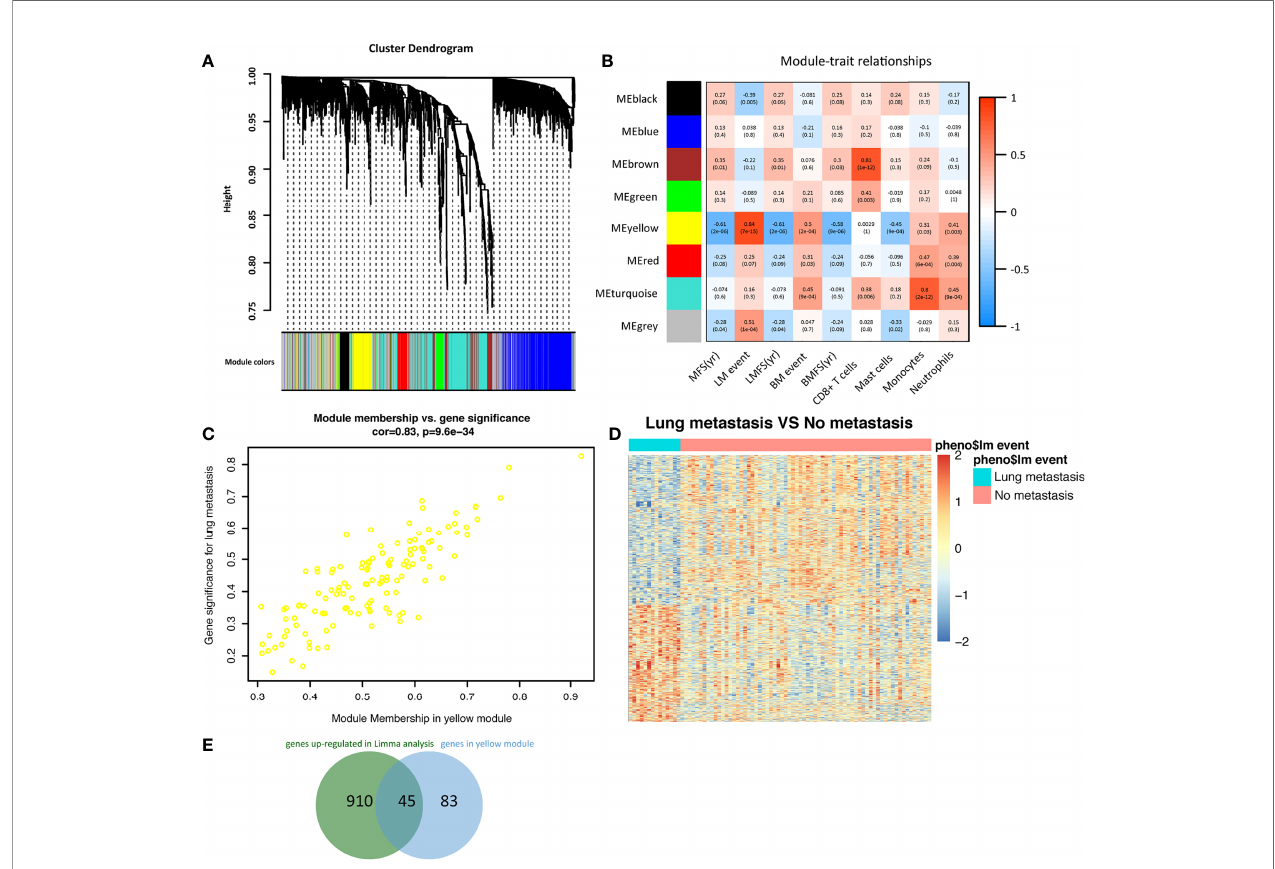
FIGURE 3 | Identi fi cation of immune-related hub genes in breast cancer metastasis to the lung. (A) A dendrogram of the immune-related genes clustered based on different metrics. Each branch in the fi gure represented one gene, and every color below represented one co-expression module. (B) A heatmap presenting the correlations between the gene modules and clinical traits. The correlation coef fi cient in each grid represented the correlation between the gene module and the clinical trait, which decreased in color from red to blue. The yellow module showed the highest positive correlation with lung metastasis. (C) The gene signi fi cance for lung metastasis and module membership of the genes in the yellow module exhibited a high correlation of 0.83. (D) Heatmap of differentially expressed genes between breast cancer patients with or without lung metastasis in the GSE2603 cohort. (E) The Venn diagram indicated the overlap between differentially expressed genes and genes in the yellow module. LM, lung metastasis; LMFS, lung metastasis-free survival; MFS, metastasis-free survival; BM, bone metastasis; BMFS, bone metastasis-free